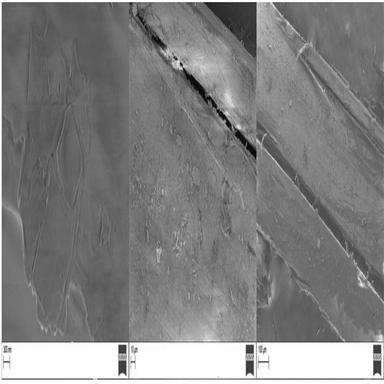
SEM images of the weathered marine rope, probably the polyethylene one, from the La Coruňa pelagial waters.